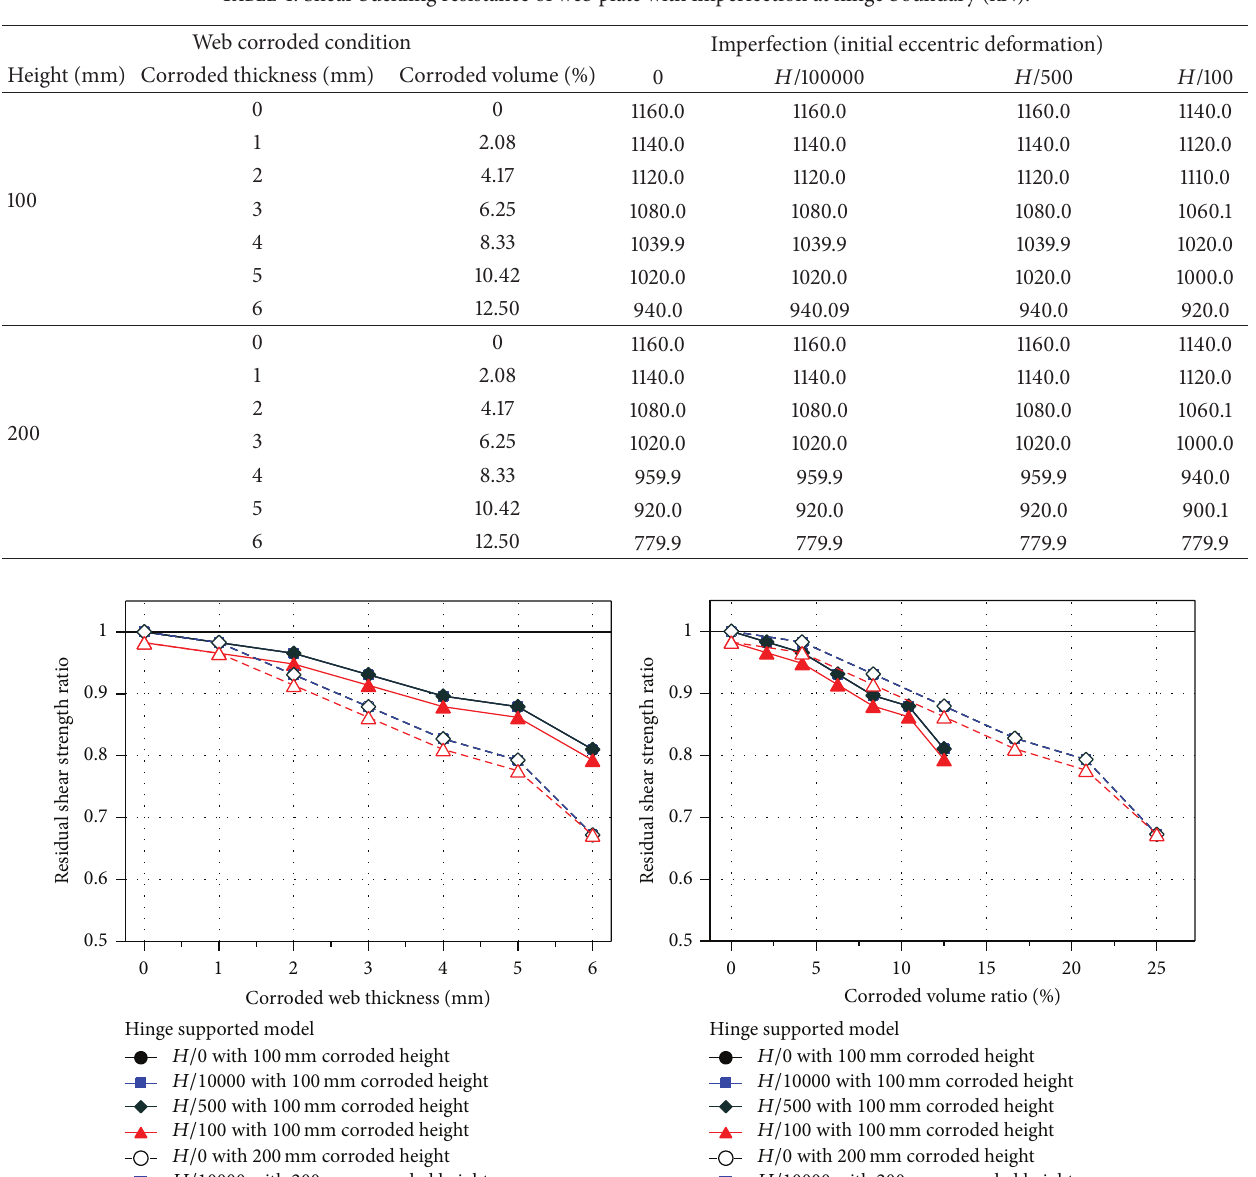
Table 4: Shear buckling resistance of web plate with imperfection at hinge boundary (kN). Web corroded condition